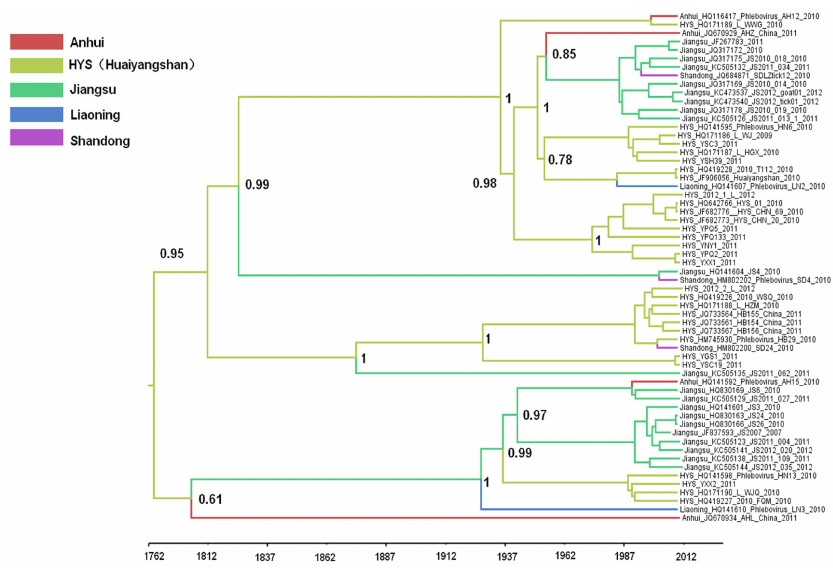
Figure 4. Maximum clade credibility tree based on L genes summarized for FTLSV were generated using the geospatial Bayesian analysis. Posterior clade probabilities for key nodes were shown. The colors of the branches correspond to their probable geographic location as calculated using the geospatial analysis.